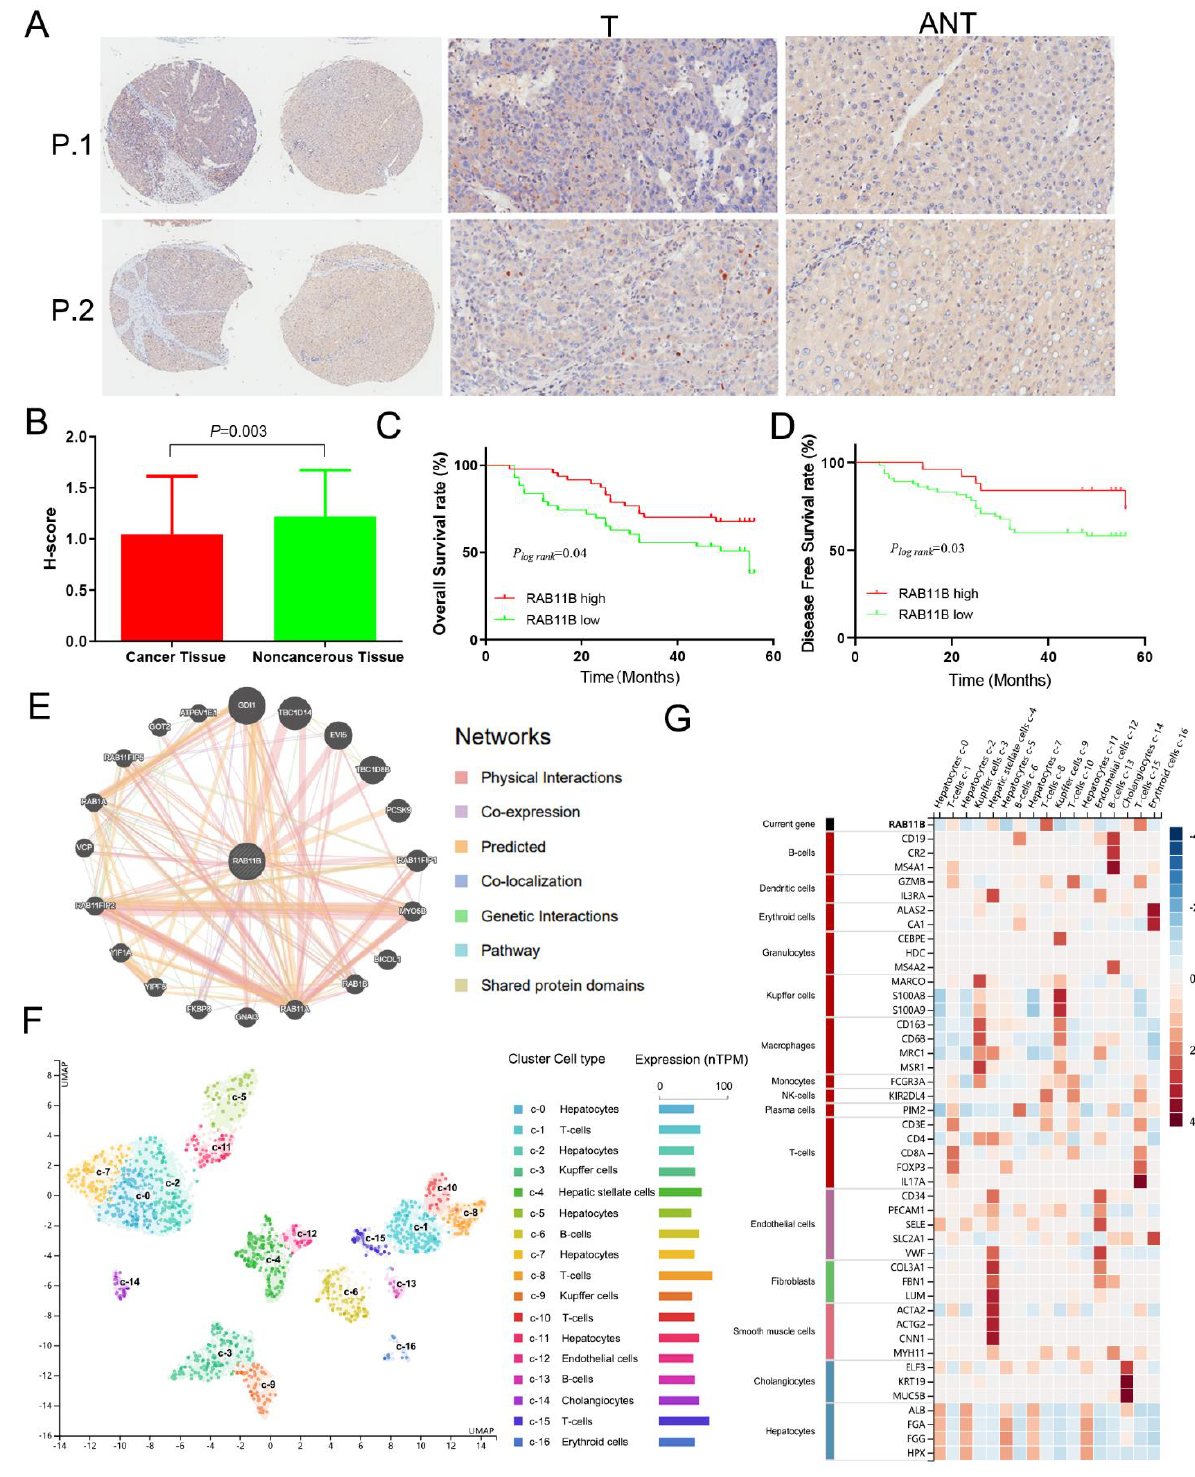
Figure 3. Immunohistochemical analysis of RAB11B protein in HCC tissues and adjacent noncancer- ous tissues. ( A ) Expression of RAB11B protein in two representative pairs of HCC tissues (T) and adjacent non-cancerous tissues (ANT), with magnification × 100. ( B ) The score histogram of RAB11B expression at protein level in HCC and non-cancerous tissues. ( C , D ) The relationship between RAB11B expression, OS, and DFS in HCC patients. ( E ) Protein network diagram of interaction with RAB11B protein. ( F ) Single-cell UMAP dimensionality reduction map of the liver. ( G ) RNA levels of RAB11B and mark genes in different single cell type clusters of the liver (Human Protein Atlas).